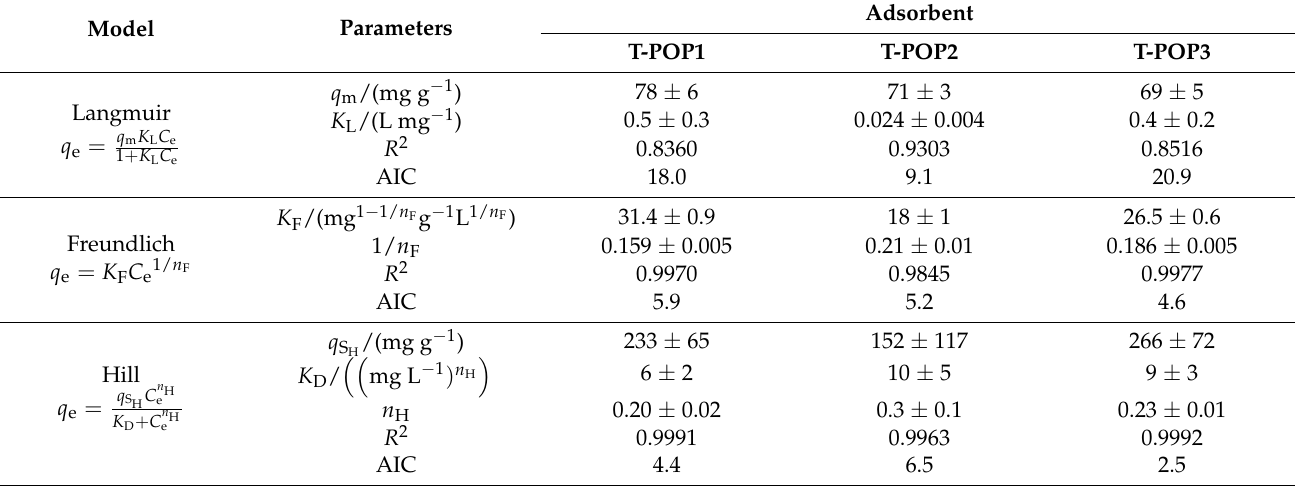
Table 2. Fitting parameters of different models of isotherms for MO adsorption.